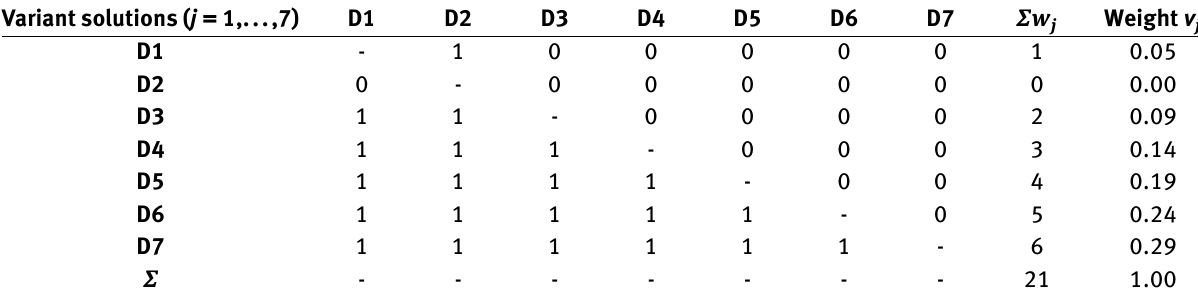
Table 3: Standardization of variant solutions weights’ according to criterion K1 [author]. Variant solutions ( j = 1,...,7)